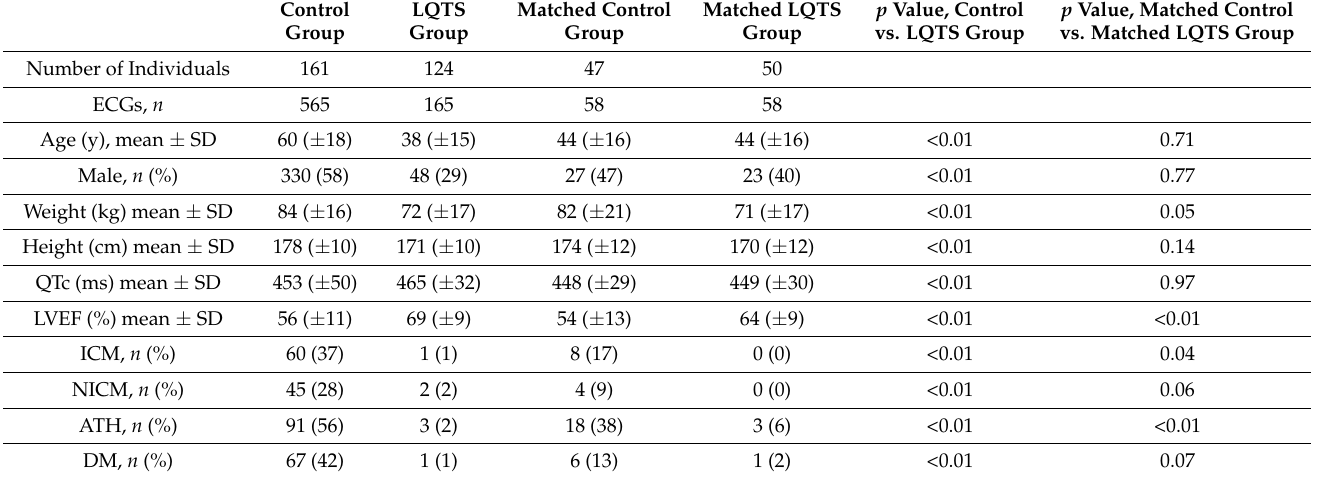
Table 1. Baseline characteristics of the study cohort separated into the LQTS, control group, and the corresponding subgroups matched according to age and QTc. LVEF, left ventricular ejection fraction; ICM, ischemic cardiomyopathy; NICM, non-ischemic cardiomyopathy; ATH, arterial hypertension; DM, diabetes mellitus; LQTS, long-QT